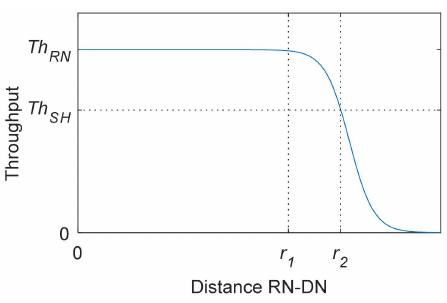
Figure 2. Two-hop MH throughput level experienced by the destination node (DN) as a function of the distance between the DN and the relay node (RN)